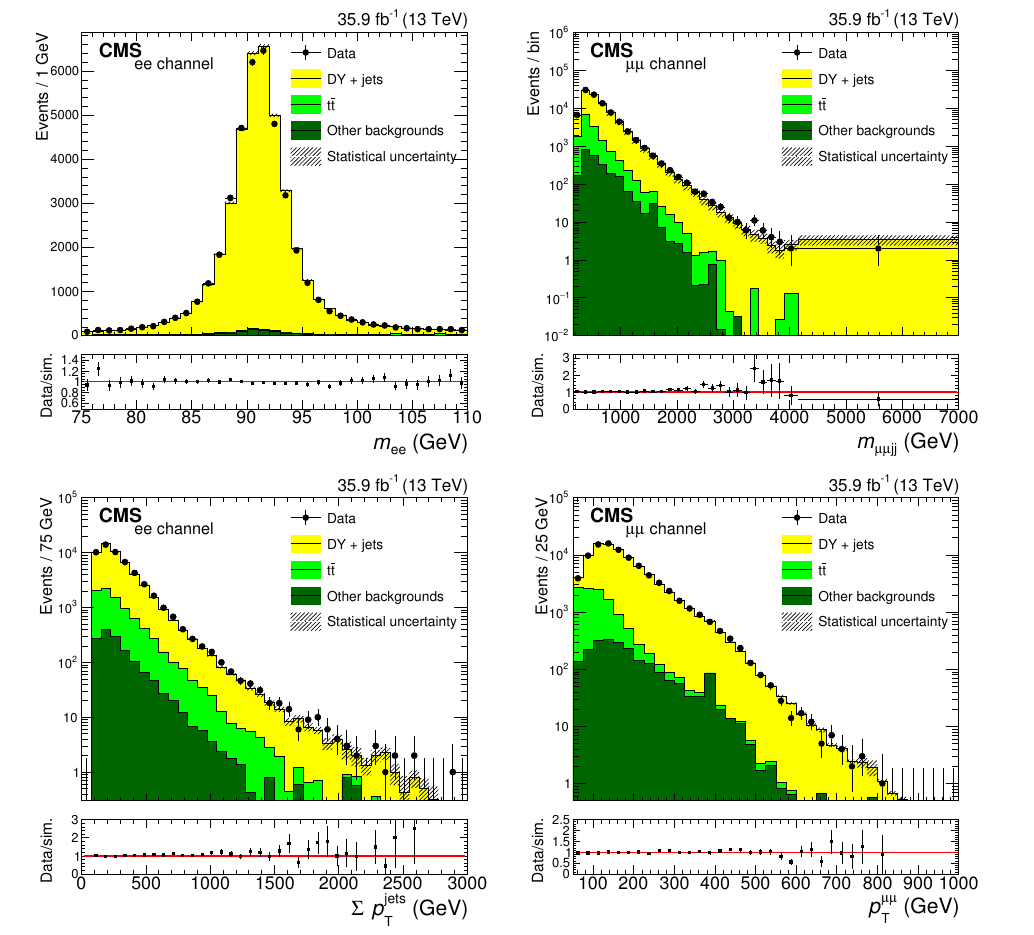
Figure 1 . Kinematic distributions for events in the low dilepton mass control region with the DY SF applied. The dilepton mass (upper left) and the scalar sum of all jet transverse momenta (lower left) are shown for the ee DY plus two jets selection. The m ‘‘ jj (upper right) and the dilepton transverse momentum (lower right) are shown for the (cid:22)(cid:22) DY plus two jets selection. The uncertainty bands on the simulated background histograms include only statistical uncertainties. The uncertainty bars in the ratio plots represent combined statistical uncertainties of data and